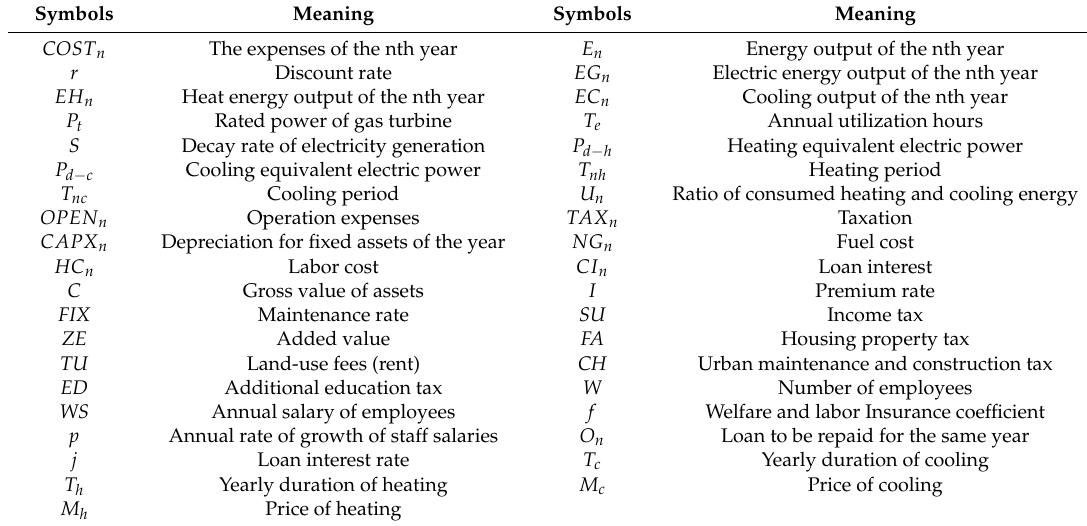
Table 6. Symbols and their meanings in the LCOE calculation equation.